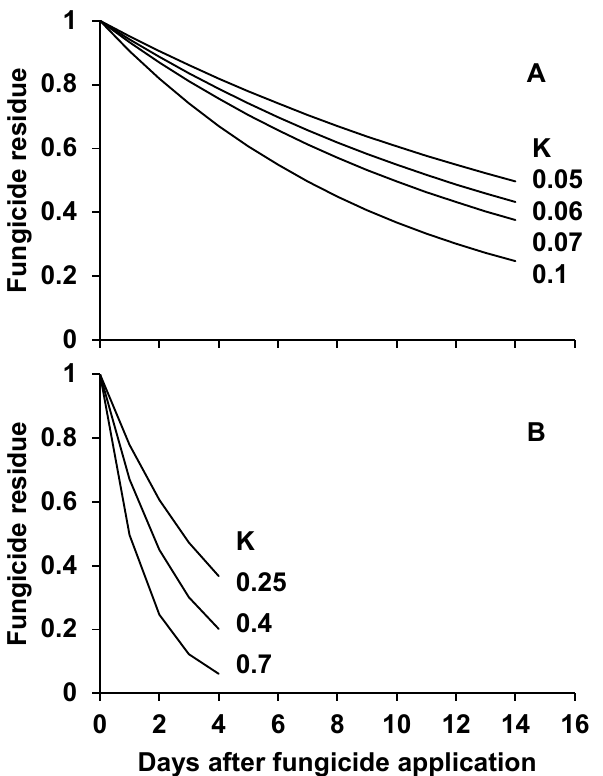
Figure 2. Changes over time in the proportion of fungicide residue remaining as calculated by equation C1 t = C 0 × exp (- K × t) [1], for (A) pre-infection activity and (B) post-infec- tion activity. C 0 is the fungicide concentration at the time of application, day 0, and is set at 1. K is the attenuation rate constant, which will differ among fungicides (K values in the figure are